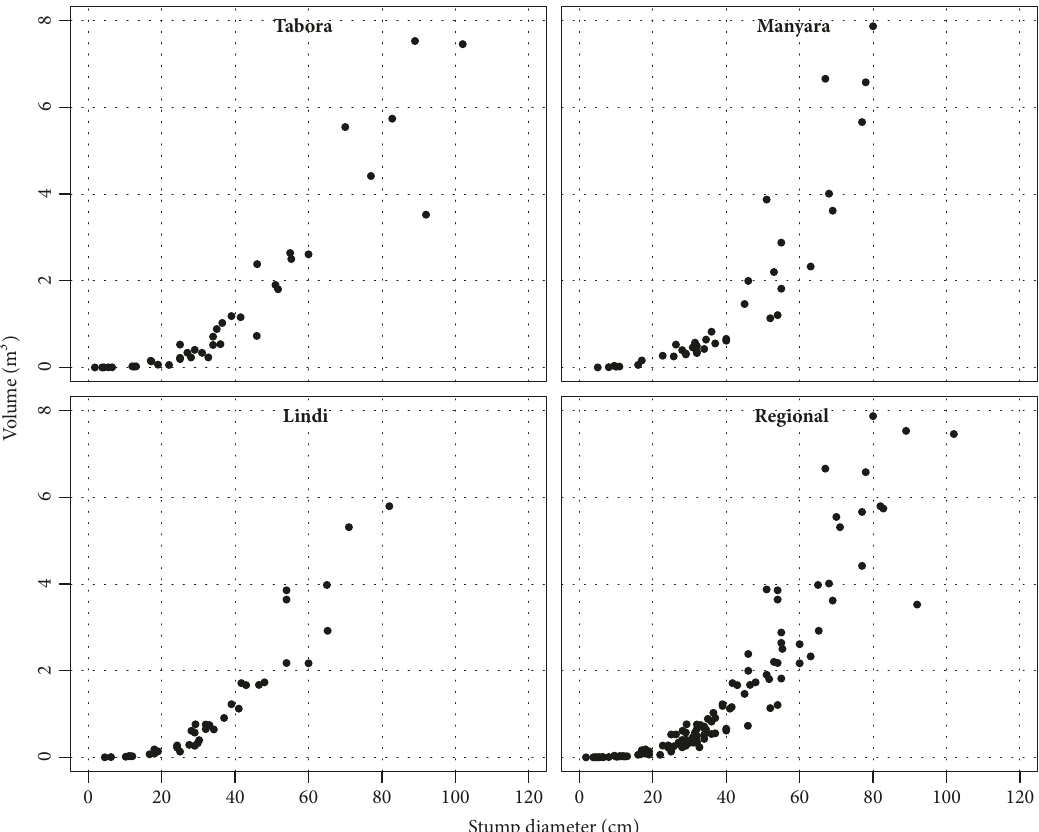
Figure 3: Scatter plots of sample trees volume distribution versus stump diameter for the three sites and all sites combined.